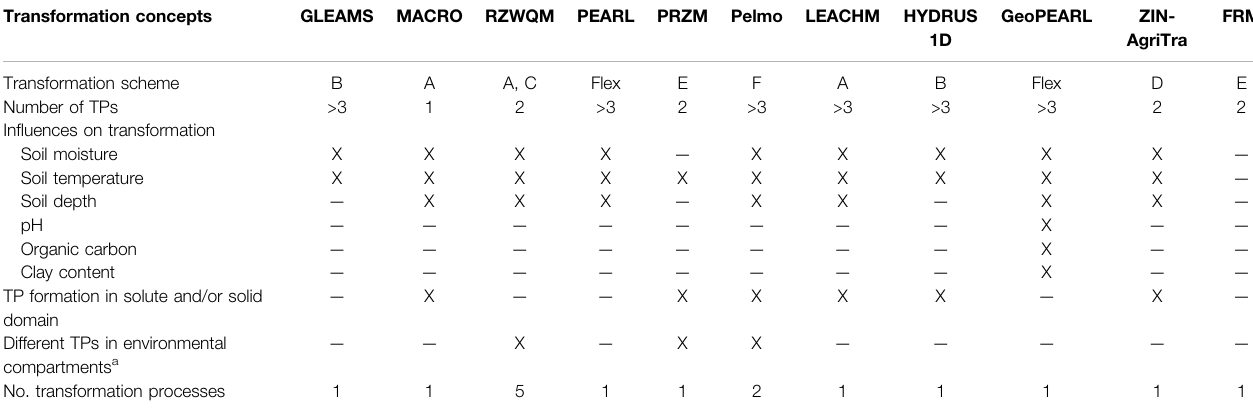
TABLE 1| Reviewedmodels and theirmodel structures regardingpesticide transformation/TP formation. “ Transformationscheme ” refersto Figure 1 . “ fl ex ” meansatotally fl exible scheme. X means the feature is included in a model. Transformation concepts